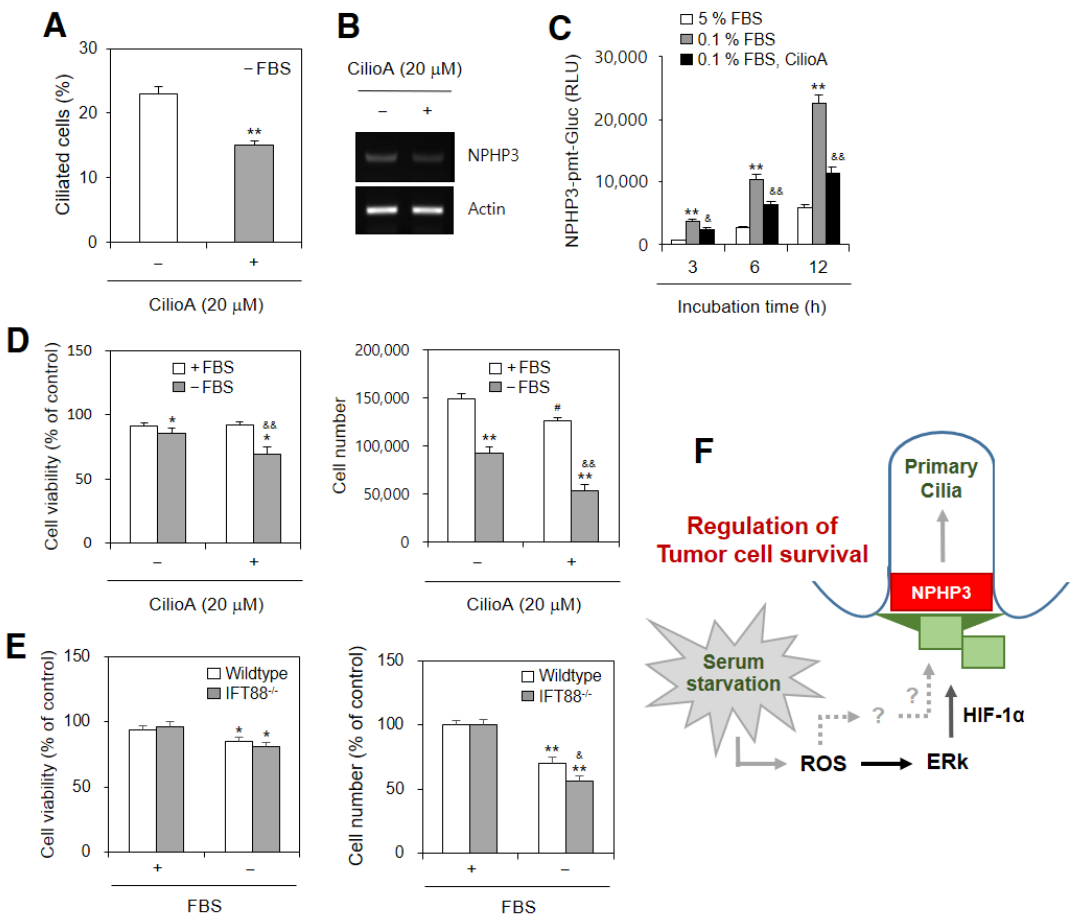
Figure 6. Ciliobrevin A inhibited cell viability, cell number and NPHP3 expression under serum- deprived (SD) condition. ( A , B ) Cells were incubated without 5% FBS in the absence or presence of ciliobrevin A (CilioA). Cells were fixed and stained with antibody against Ac-tubulin (green) and DAPI (blue). The primary cilium was observed with 1000 × magnification under fluorescence microscope. The ciliated HeLa cells ( n > 500 cells) in the absence (white) or presence (grey) of CilioA were counted ( A ). Total RNA was prepared by using NucleoZOL ® and the expression level of NPHP3 was measured by RT-PCR ( B ). ( C ) Cells were transfected with pEZX-PG02-NPHP3-promoter-Gluc plasmids and incubated in the absence or presence of CilioA for up to 12 h. The activity of Gluc in cultured media was measured with luminometer using Gluc substrate. ( D , E ) HeLa ( D ) or PC- deficient IFT88 − / − A375 ( E ) cells were incubated with or without FBS for 24 h. Cell viability was measured by the trypan exclusion assay ( D – E left). Cell number was counted using a hemocytometer ( D , E right). Data were representative of four experiments. Processing (such as changing brightness and contrast) is applied equally to controls across the entire image ( B ). Data in bar ( A , C – E) graphs represents the means ± SEM. * p < 0.05, ** p < 0.01; significantly different from CilioA-untreated ( A ) or 5% FBS-treated group ( C – E ) at each time point ( C ). # p < 0.01; significantly different from CilioA- untreated group with FBS ( D ). & p < 0.05, && p < 0.01; significantly different from CilioA-untreated group without FBS ( C , D ) at each time point ( C ) or wildtype group without FBS ( E ). ( F ) Scheme for primary cilium formation by serum starvation-induced ROS through ERK activation, HIF-1 α and NPHP3 expression to regulate tumor cell survival. While HIF-1 α regulated NPHP3 expression and primary cilium formation via ERK activation in HeLa human cervical cancer cells (solid line). ROS also up-regulate NPHP3 expression through unknown another factors (marked as question marks and grey dotted lines). Our findings were indicated by black solid lines. Pathway already known was indicated by grey solid